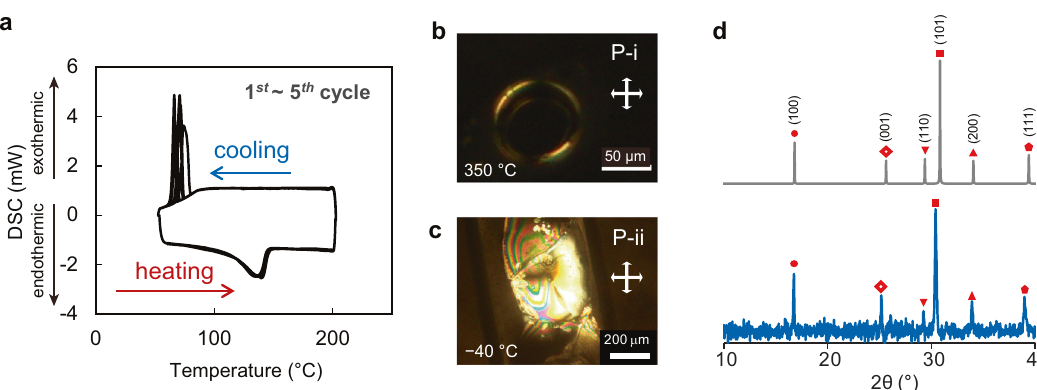
Fig. 3 Thermal properties of BoL-LC. a DSC curves corresponding to cooling and heating of BoL-LC. BoL-LC transitions from the P-i to the P-ii phase at ~100 °C during cooling and from the P-ii to the P-i phase at approx. 150 °C during heating. The P-i ( b ) and P-ii ( c ) phases in a glass capillary observed by polarized optical microscopy under crossed polarizers (white double arrows) at room temperature. d X-ray diffraction (XRD) peaks of the sample at room temperature (blue). The spectra in gray show peaks calculated from the obtained single-crystal data of